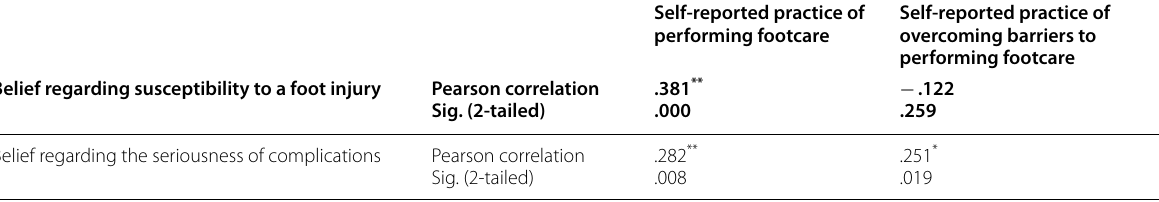
*Correlation is significant at the 0.05 level (2‑tailed) **Correlation is significant at the 0.01 level (2‑tailed)